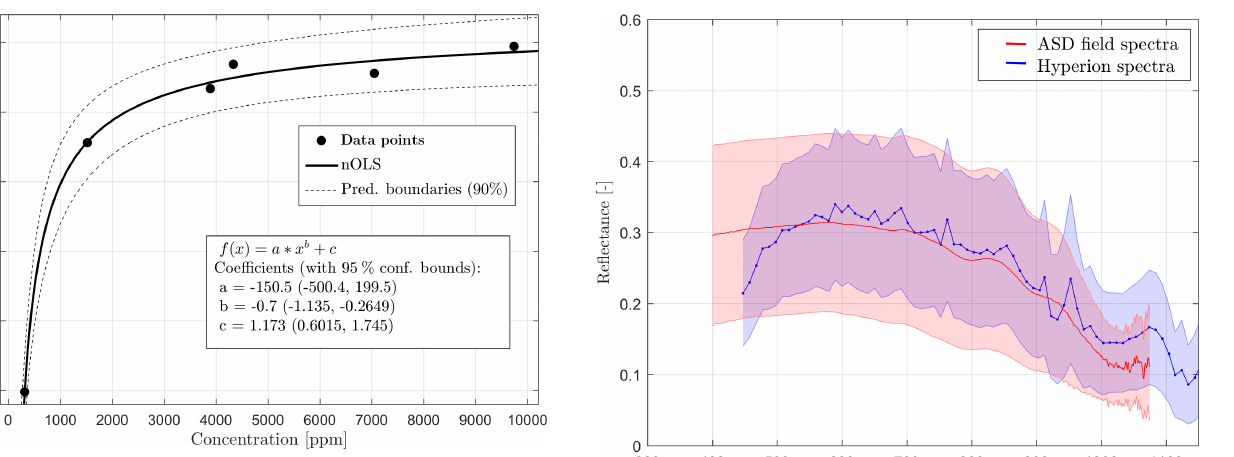
Figure 3. Nonlinear ordinary least squares (nOLS) regression ( R 2 = 0 . 9) between the impurity index ( I imp ) and the concentra- tion of impurities found in samples of clean and dirty ice. Model description is displayed in the box.